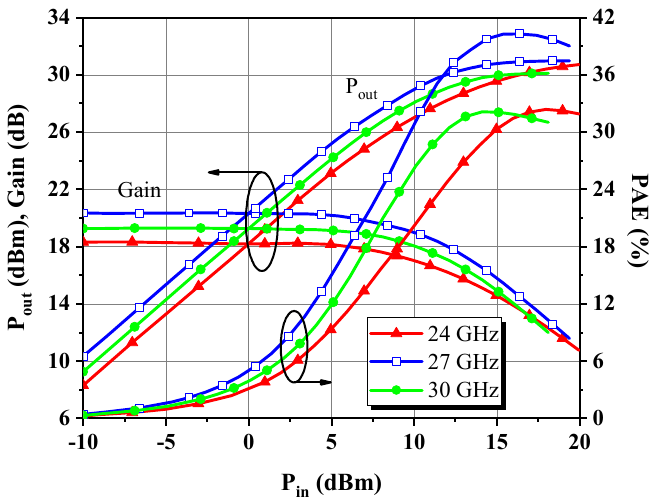
Figure 25. Measured P out , PAE, and gain behaviors with respect to P in at three equally spaced frequencies across the objective band.